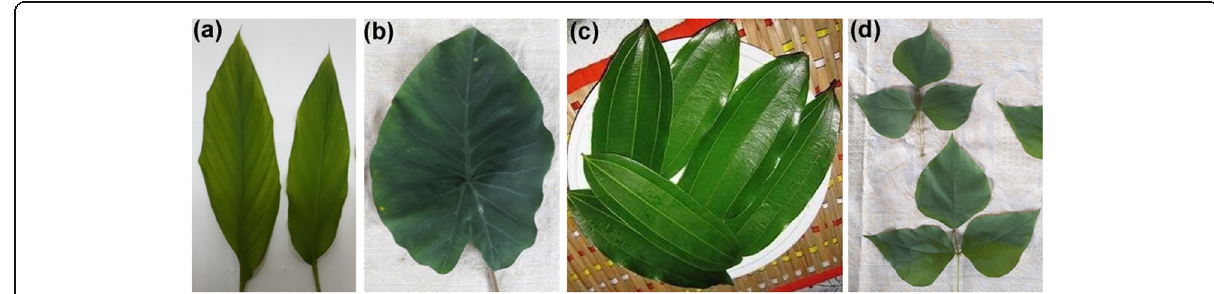
Fig. 7 a The leaves of turmeric, C. longa , ( b ) the leaves of taro, C. esculenta ( c ) the leaves of therali , C. malabathrum and ( d ) the leaves of Indian bean L.